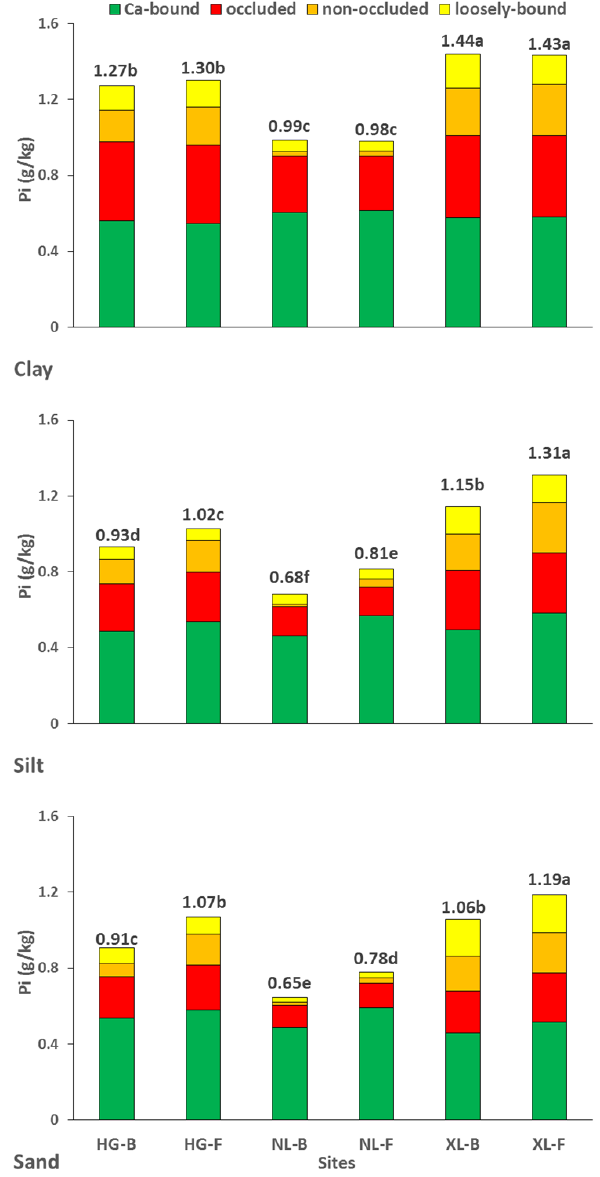
Figure 5. The P storage in particle-size fractions for Pi fractions of different land use sites. Values above the columns are the sum values of Pi fractions at the same site. Values followed by a similar letter are not significantly different at P< 0 . 05 level of significance according to the LSD test. For abbreviations, see Fig.